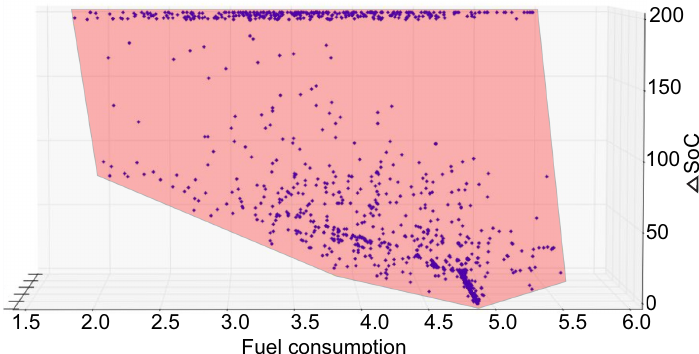
Figure 22. Conflict of objectives.